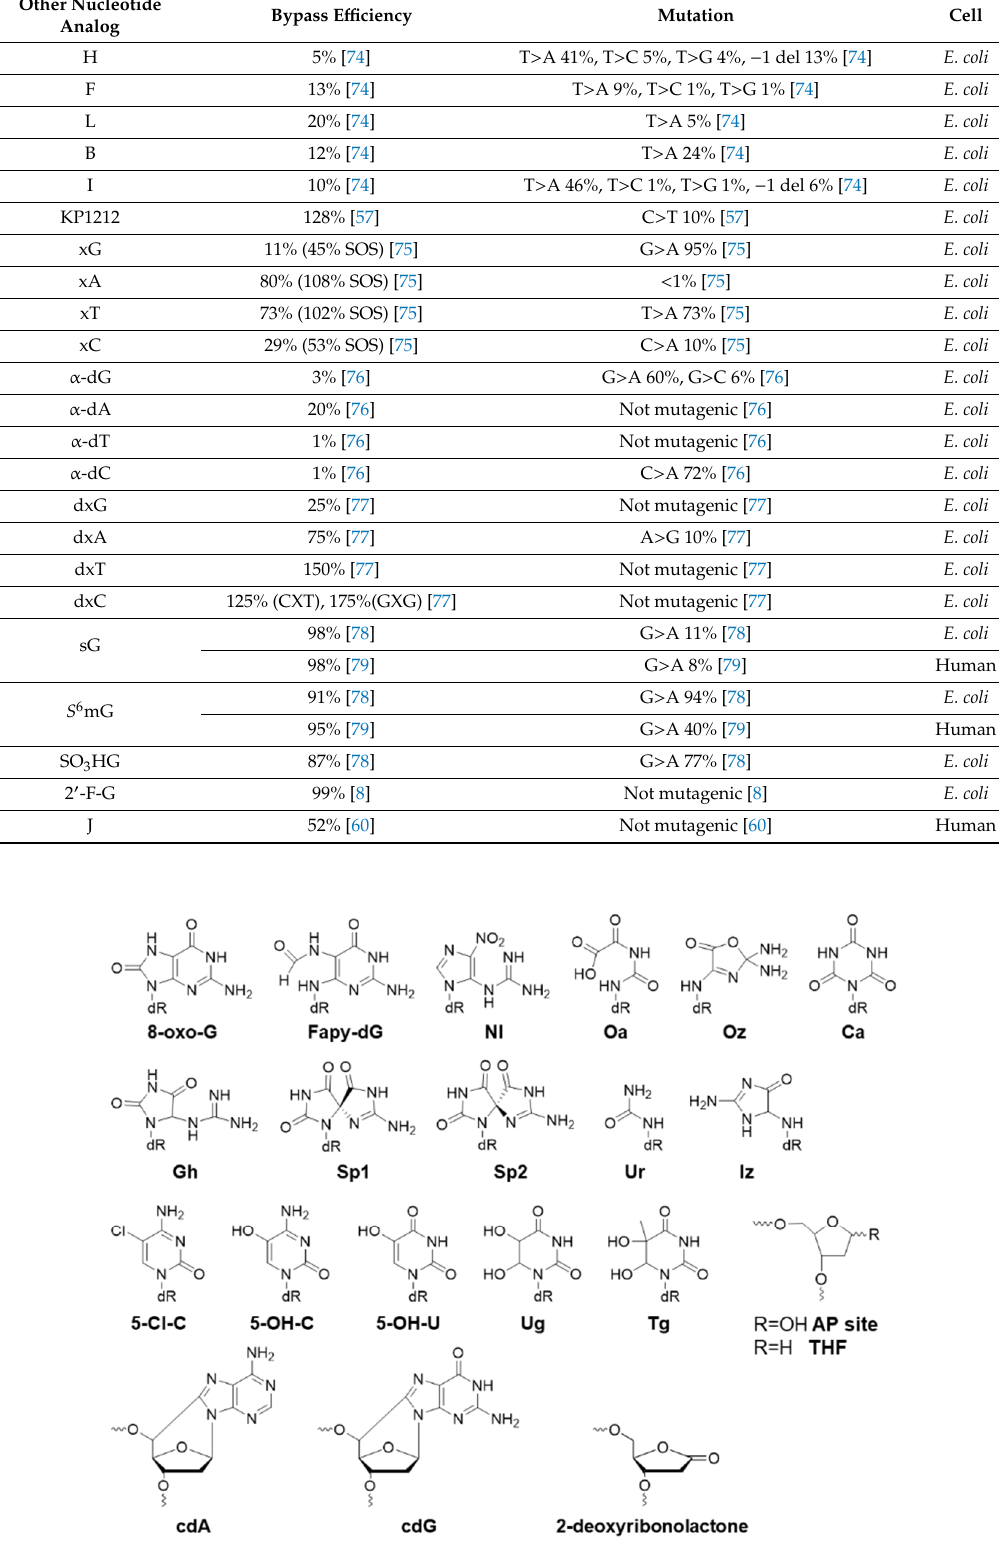
Figure 3. Structures of alkyl modifications (continued on the next page).